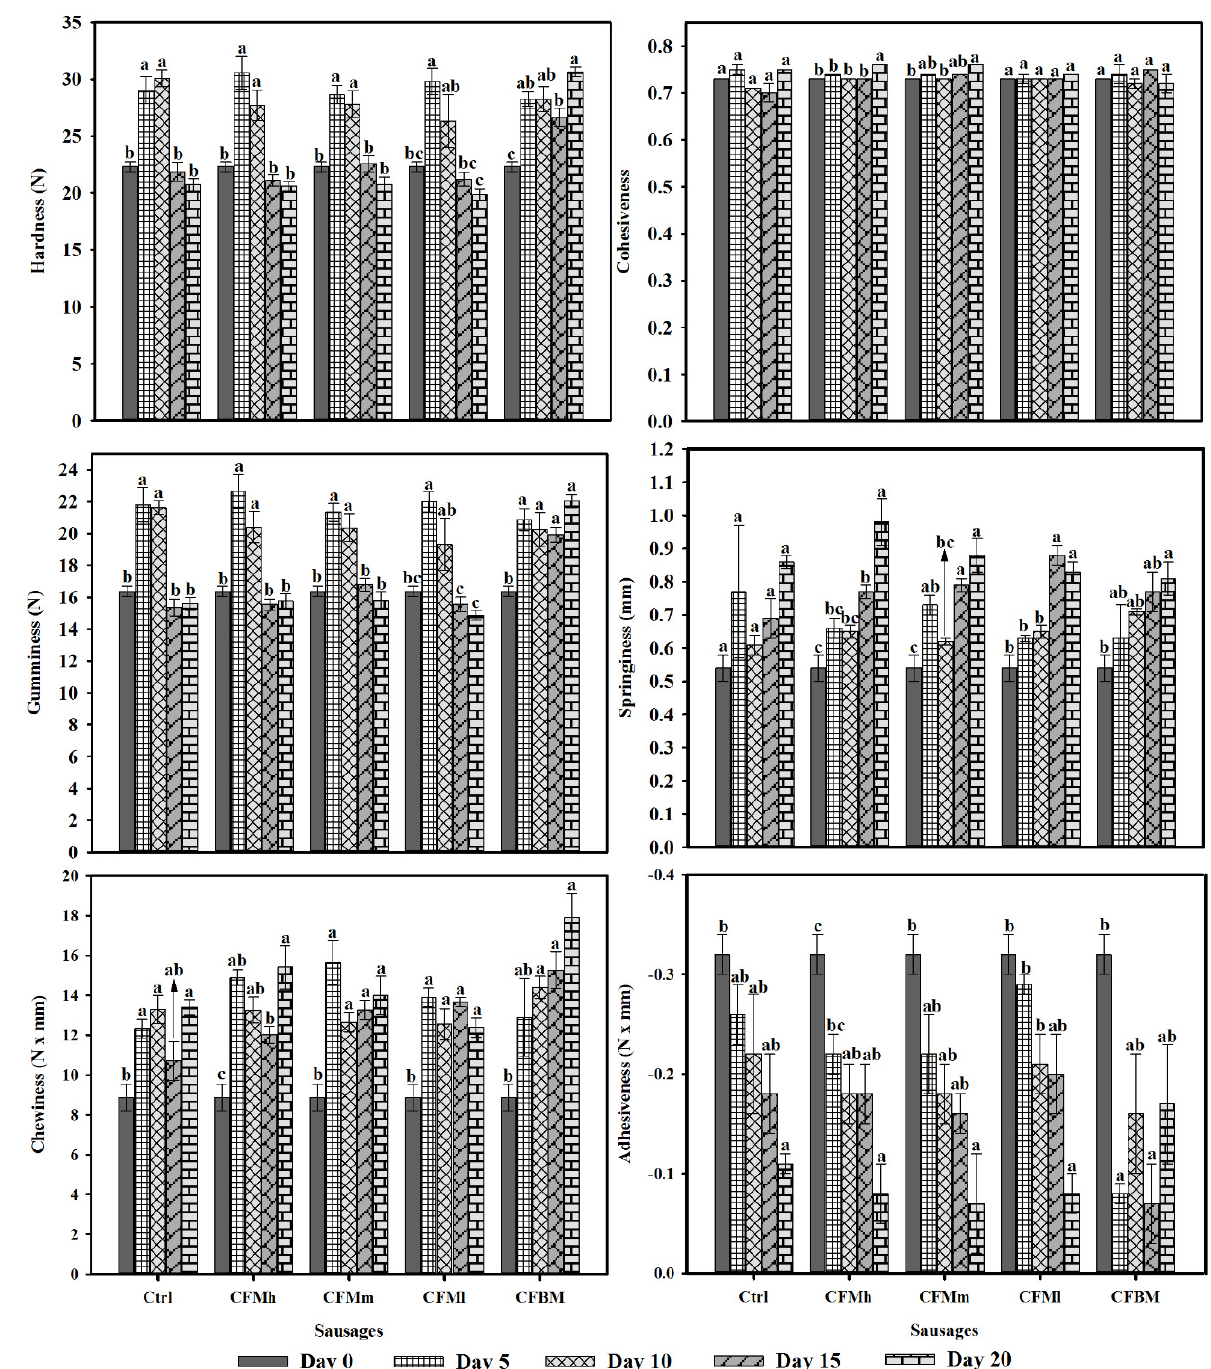
Figure 2. Texture profile analysis in covered sausages with chitosan Brachystola magna films (CFBM) and commercial high (CFMh), medium (CFMm) and low (CFMl) molecular weight chitosan films, as well as uncovered sample (Ctrl) during storage (0–20 days) at refrigeration (4 ± 1 °C). Results are arithmetic mean from at least three repetitions ± standard error. Bars connected by the same lowercase letters (a-c) in treatments are not significantly different among storage times ( p ≥ 0.05) by Tukey´s test.